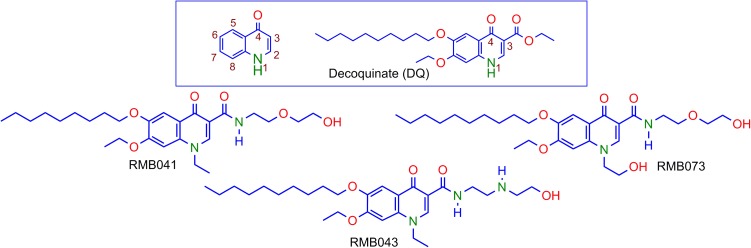
Numbering of the quinolone scaffold and structure of decoquinate (DQ) (box), and the DQ derivatives RMB041, RMB043, and RMB073.